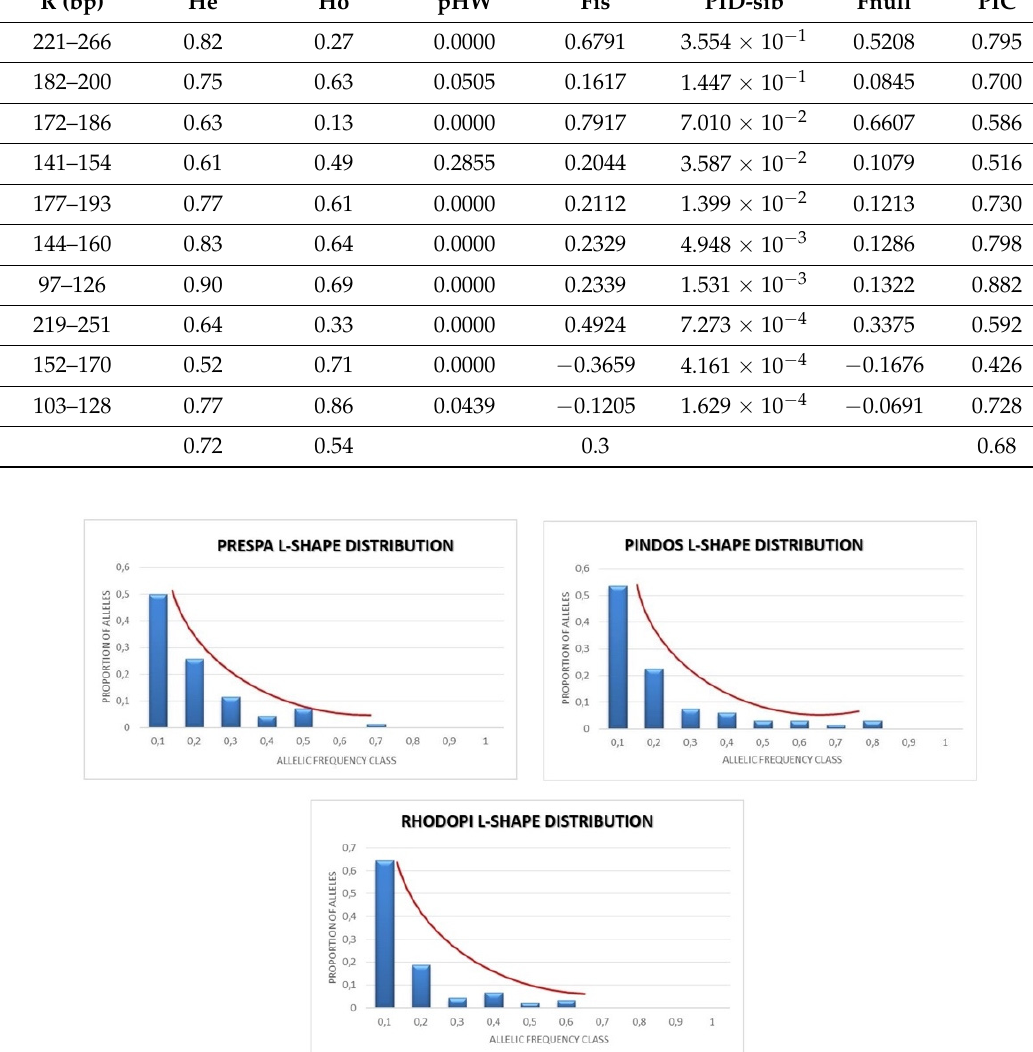
Table 7. Genetic information about the population of brown bears from Rhodopi NP. Number of alleles (A); allele size per bp (R); observed heterozygosity (Ho); expected heterozygosity (He); p - value for Hardy–Weinberg Equilibrium (pHW); inbreeding coefficient (Fis); probabilities of identity